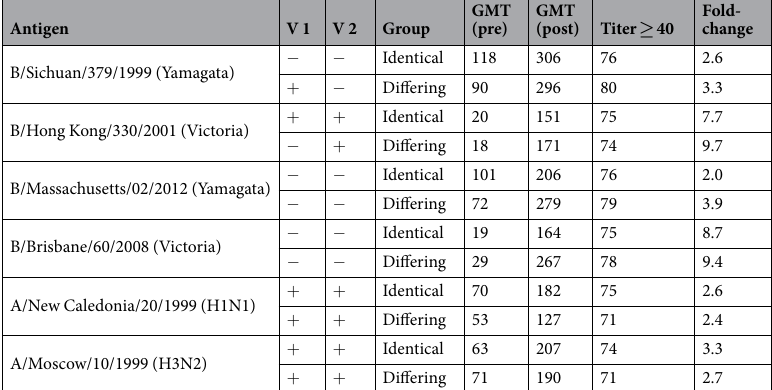
Antigen V 1 V 2